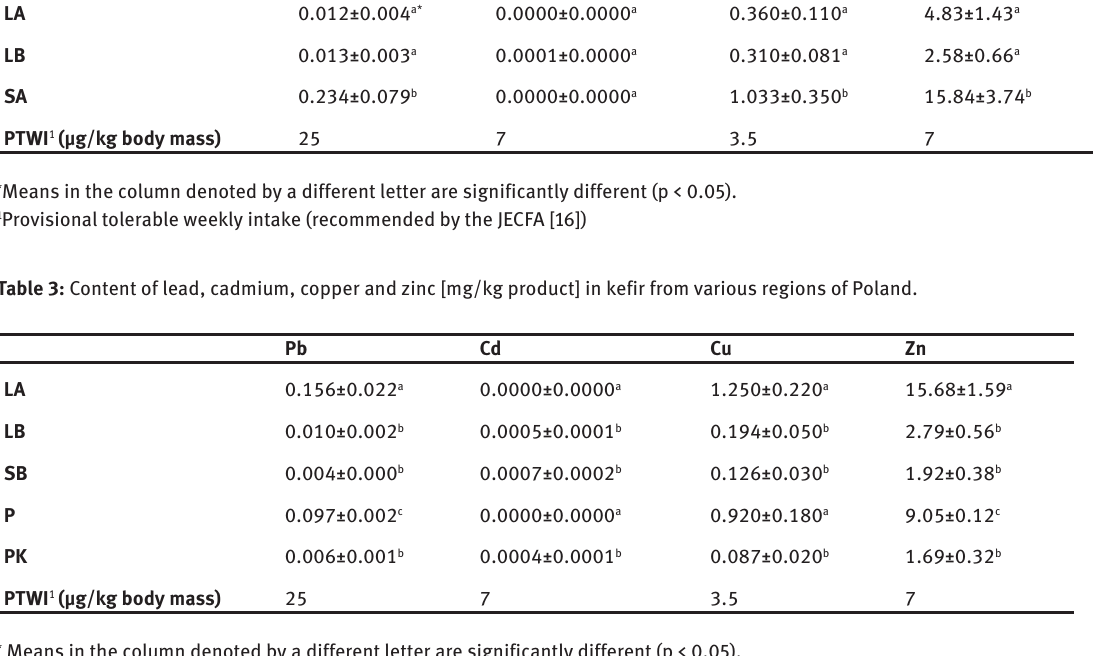
Table 2: Content of lead, cadmium, copper and zinc [mg/kg product] in milk from various regions of Poland. Pb